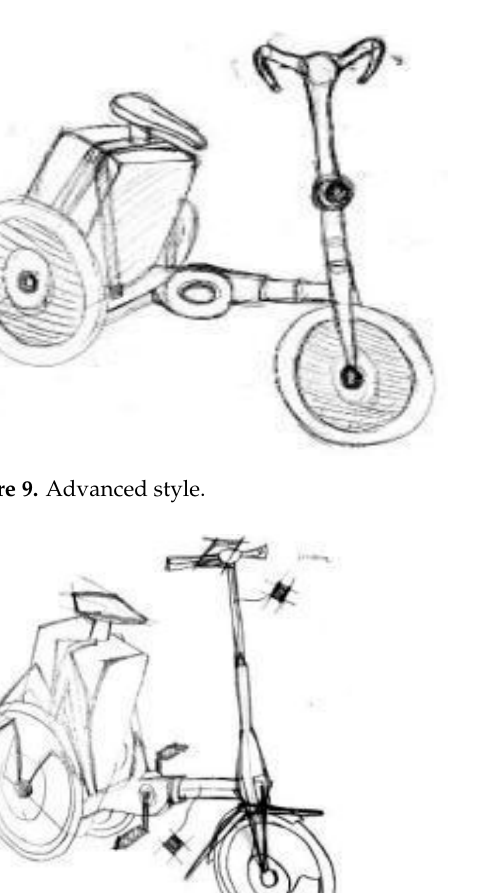
Figure 8. Retro style.